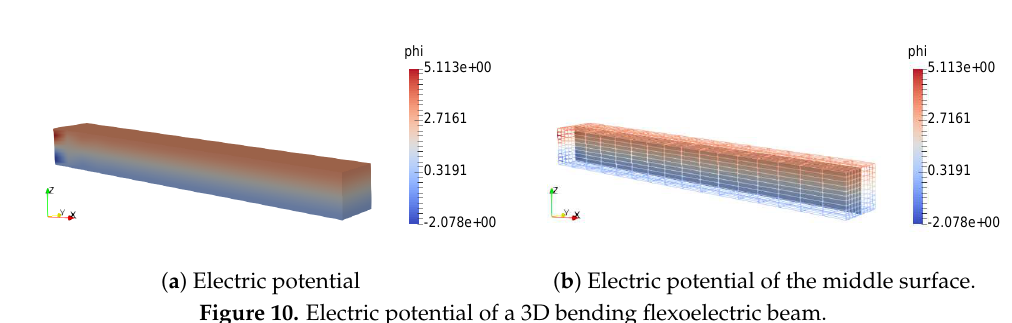
Figure 10. Electric potential of a 3D bending flexoelectric